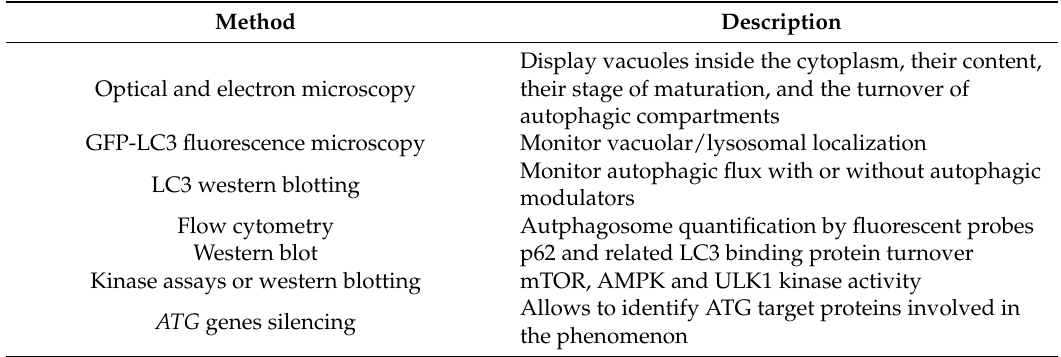
Table 2. The main in vitro methods for monitoring